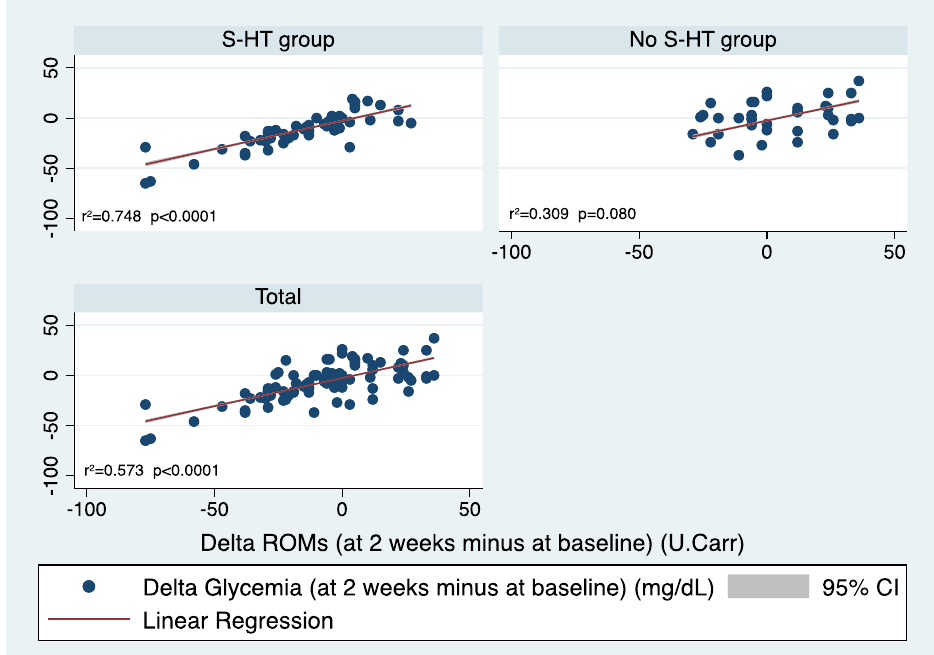
Figure 2. Linear regression results in the S-HT and No S-HT groups, and in the overall population.